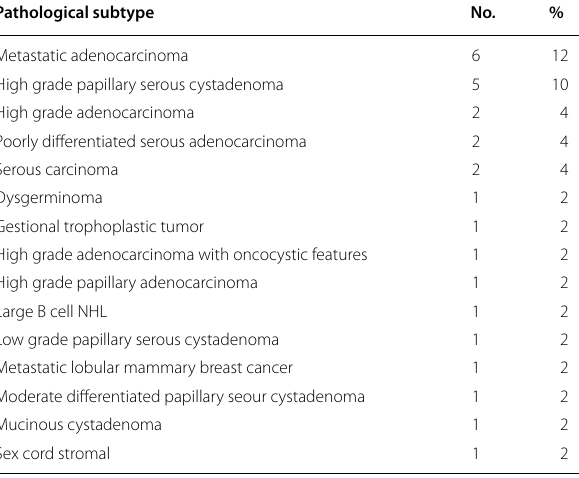
Table 1 Distribution of pathological subtype of all studied cases Pathological subtype